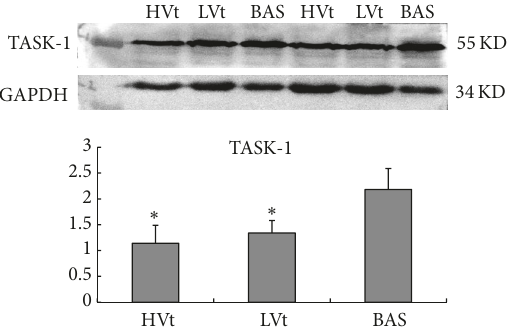
Figure 4: Western blotting analysis of TASK-1 levels in each group . Significant decreases in the TASK-1 channel levels in the HVt and LVt groups were observed. The HVt group tended to have a lower level of TASK-1 than the LVt group. Results are presented as mean ± SD. ∗ 𝑃 < 0.013 versus the basal group (HVt versus BAS 𝑃 = 0.002 , 𝑈 = 3 ) (LVt versus BAS 𝑃 = 0.002 , 𝑈 = 2 ). 𝑁 = 8 animals per group. BAS, basal; LVt, low tidal volume; HVt, high tidal